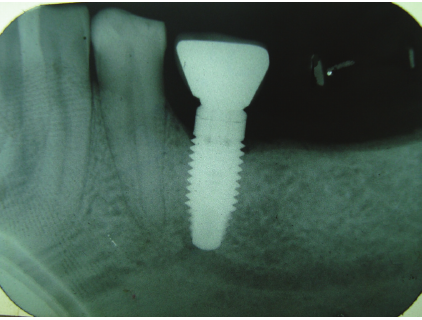
Figure 5: IOPA radiograph 3 months after prosthetic rehabilitation.